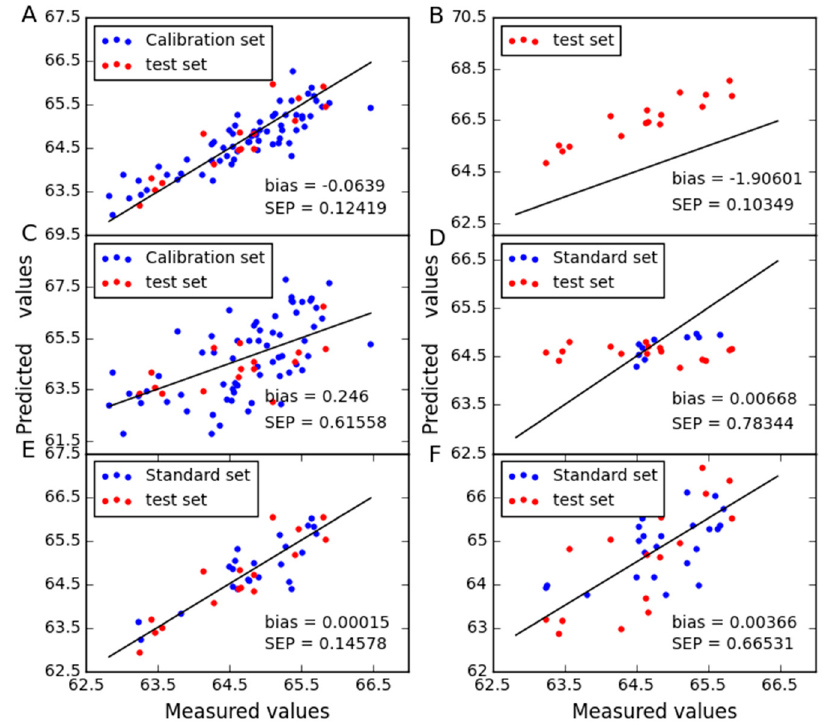
Figure 6. Starch content predicted for corn dataset as determined by ( A ) CTAI, ( B ) MSC, ( C ) TCR, ( D ) CCA, ( E ) SBC and ( F ) PDS. The blue and red dots represent the results for each sample in the train set and test set, respectively.